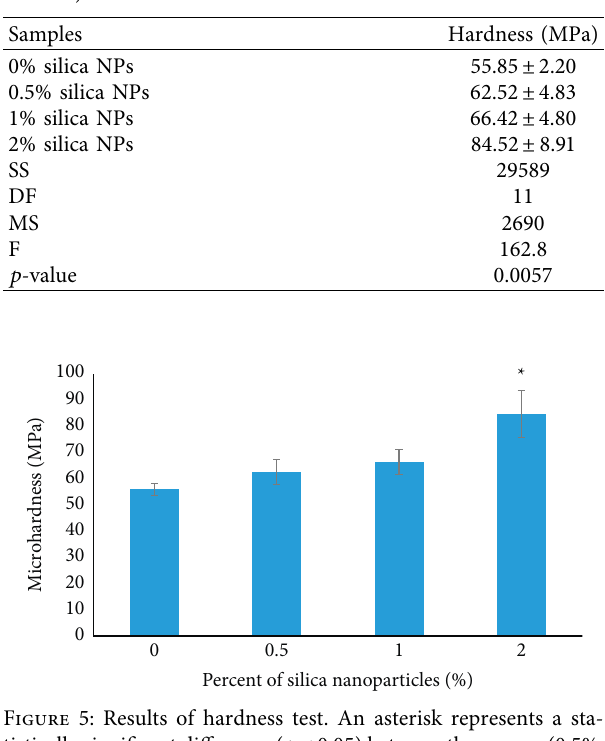
Table 3: Results of hardness test for the groups (0%, 0.5%, 1%, and 2%).